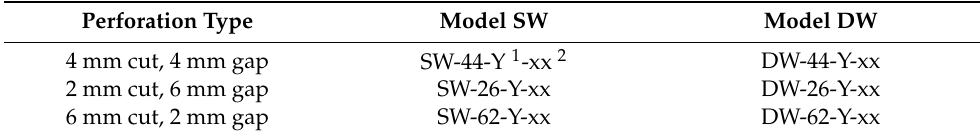
Table 2. Sample symbols.